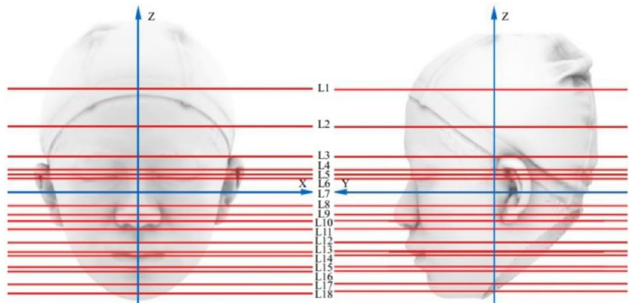
Fig. 6. Layering of a scanned three-dimensional